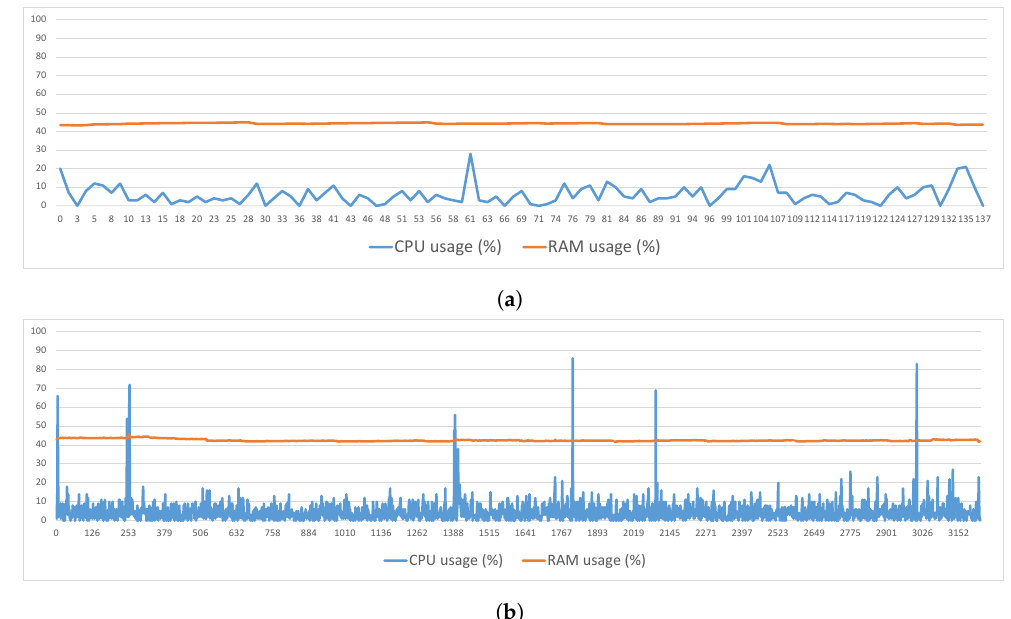
Figure 2. Symmetric key generation—RAM and CPU usage. ( a ) RAM and CPU usage—100 entities, ( b ) RAM and CPU usage—500